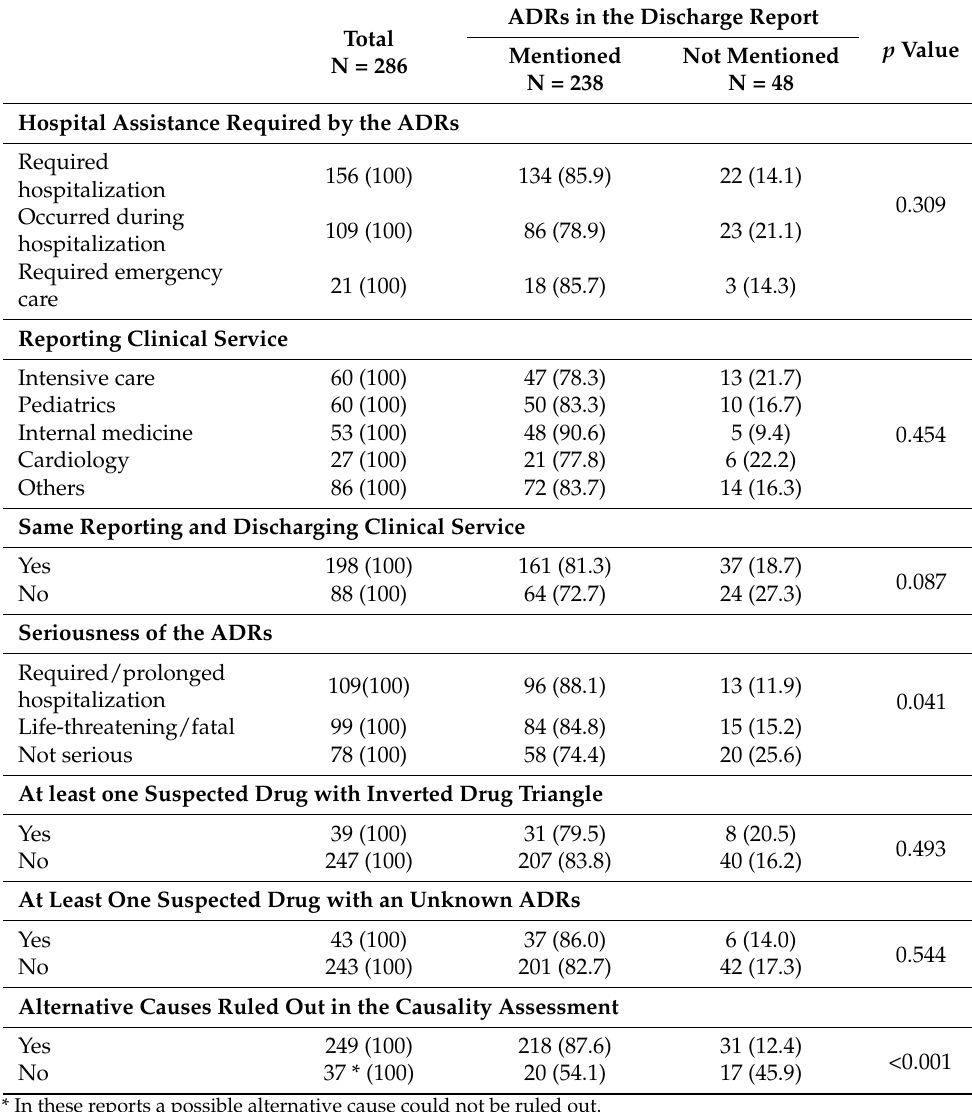
Table 2. Bivariant analysis of factors associated with the mention of adverse drug reactions in the discharge